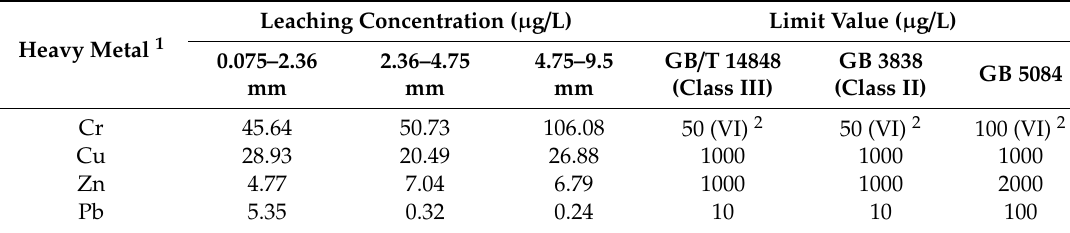
Table 2. Leaching concentrations of heavy metals from MSWI-BAA by the HVEP